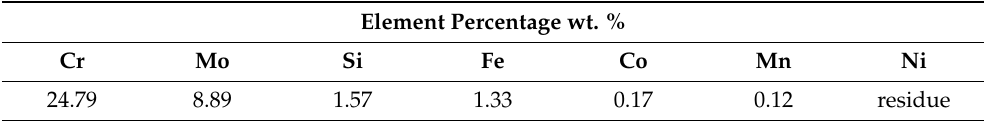
Table 1. Chemical composition of tested